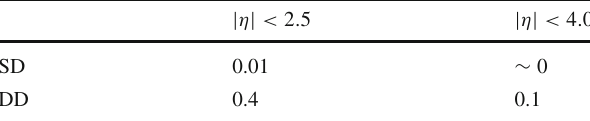
tonproductionafterapplyingallcutsspecifiedinTable2of[14].Results for single and double proton dissociation are given, and with different pseudorapidity intervals for both the final-state leptons and rapidity veto. Lepton reconstruction efficiencies are taken from [63]. The values marked as ∼ 0 correspond to numbers which are sufficiently below